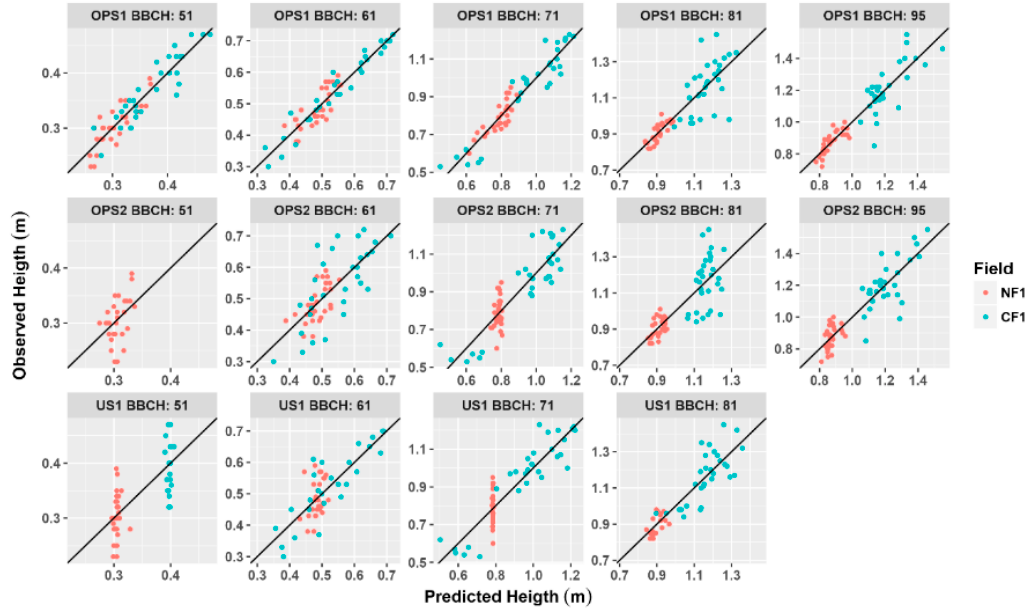
Figure A1. Crop height prediction in five crop stages according to BBCH scale using three crop sensors: OPS1: N-Sensor™ ALS; OPS2: Crop Circle ACS 430; US1: Polaroid 6500, for cotton cultivated in two systems: narrow row (NF1) and conventional row spacing (CF1).